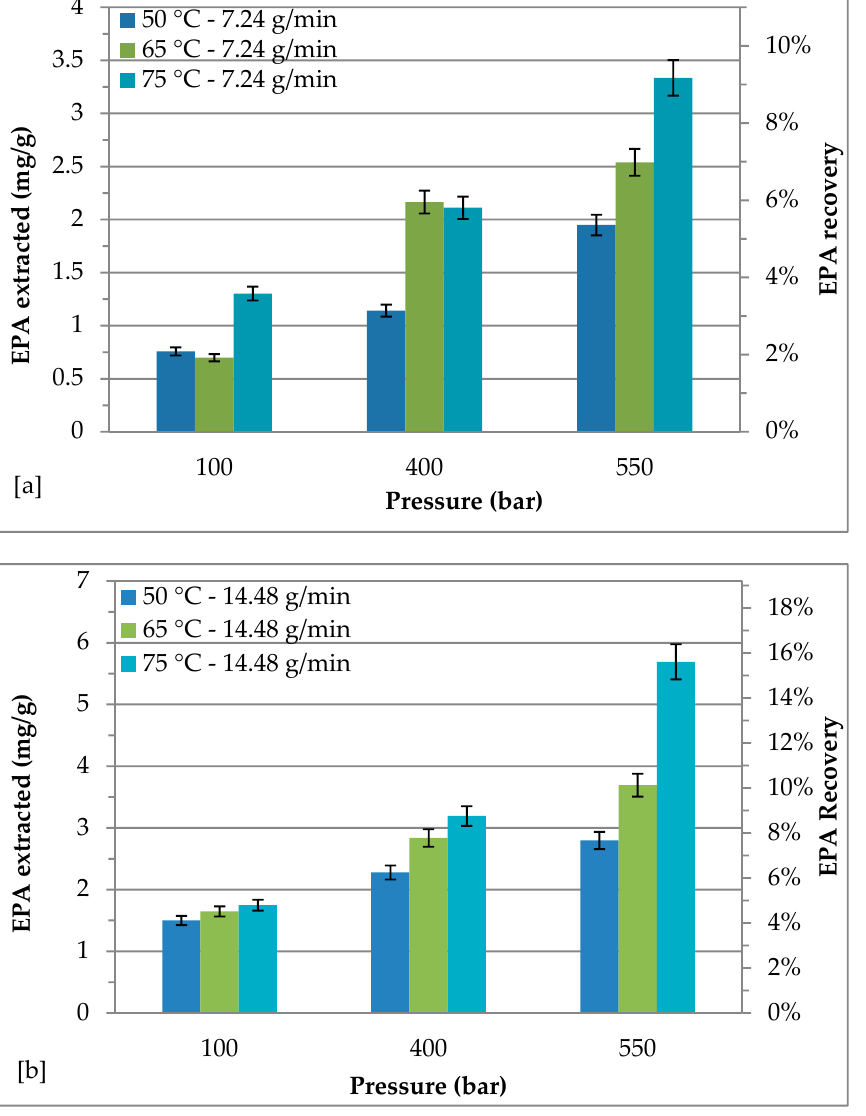
Figure 2. Effect of different pressure and temperature on recovery of eicosapentaenoic acid (EPA): ( a ) Figure 2. E ff ect of di ff erent pressure and temperature on recovery of eicosapentaenoic acid (EPA): CO 2 flow rate = 7.24 g/min; ( b ) CO 2 flow rate = 14.48 g/min. ( a ) CO 2 flow rate = 7.24 g / min; ( b ) CO 2 flow rate = 14.48 g / 2.4. Effect of Different Pressure and Temperature on DHA Recovery with a CO 2 Flow Rate of 7.24 and 14.48 g/min